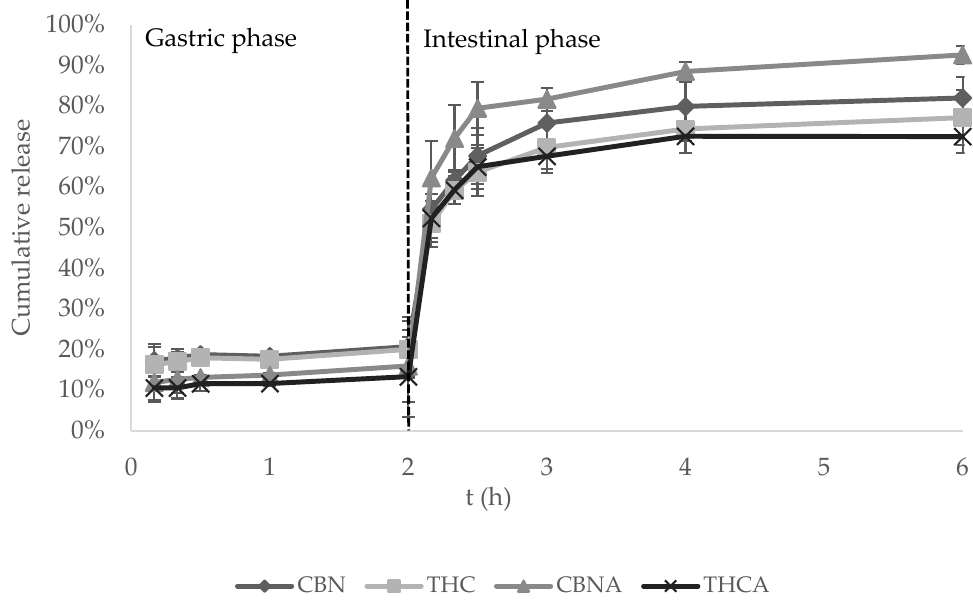
Figure 4. Gastrointestinal cumulative release (%) of CBN, THC, CBNA and THCA.